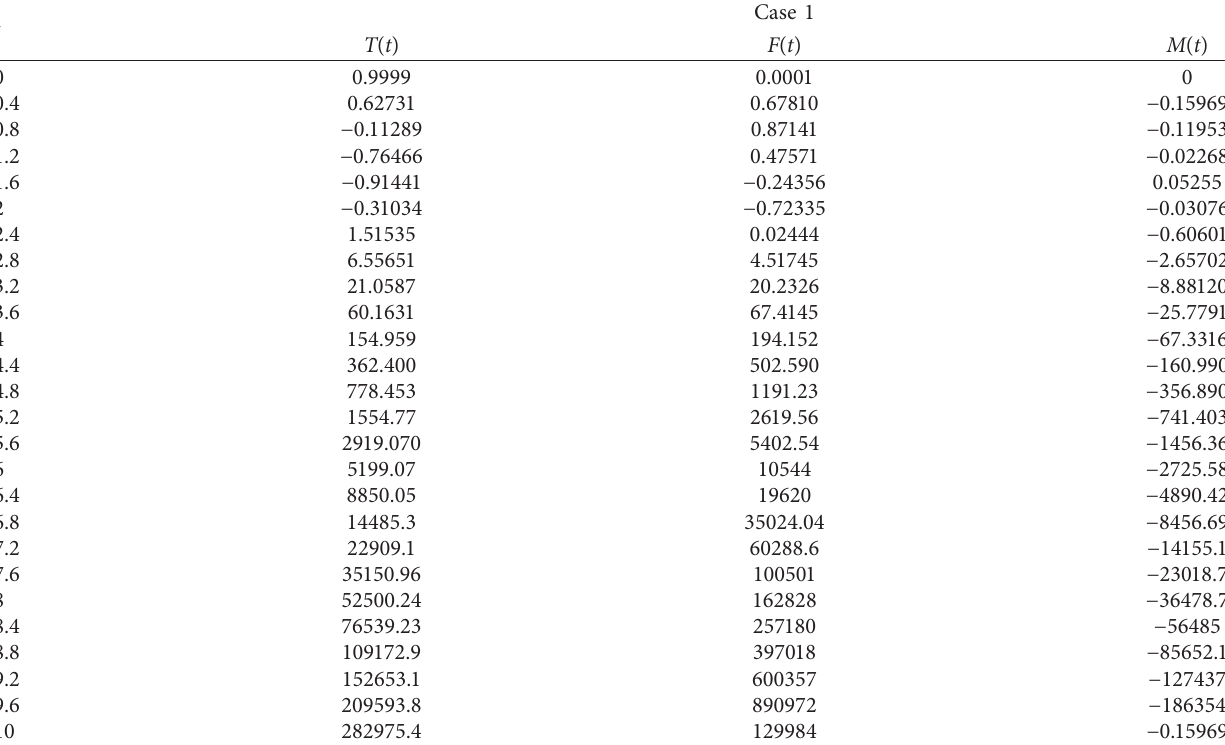
Table 2: Numerical investigations of the T ( t ), F ( t ), and M ( t ) for Case 1 of the TFM model.